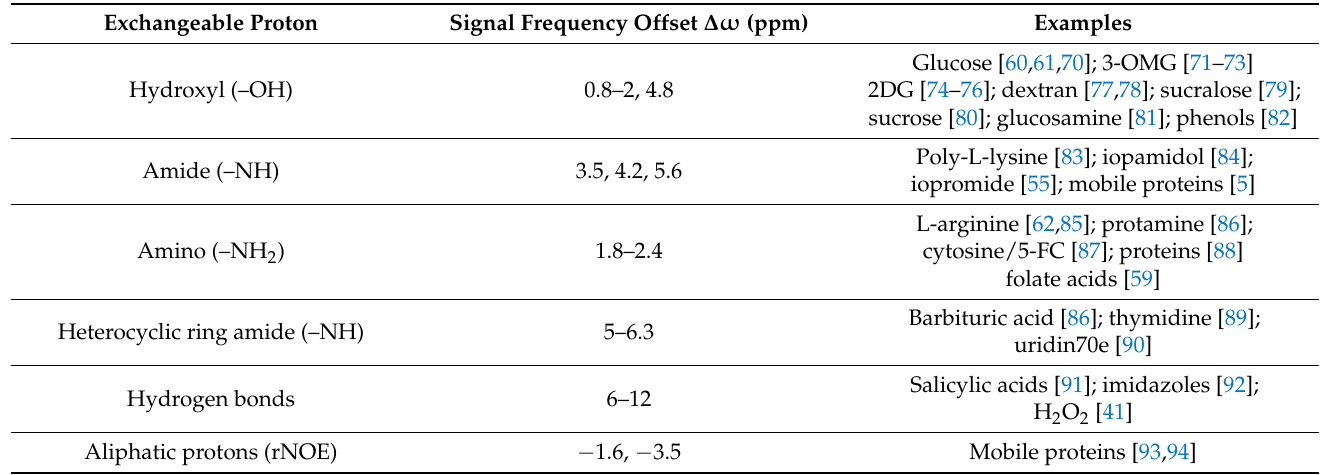
Table 1. DIACEST library (Reprinted with permission from Ref